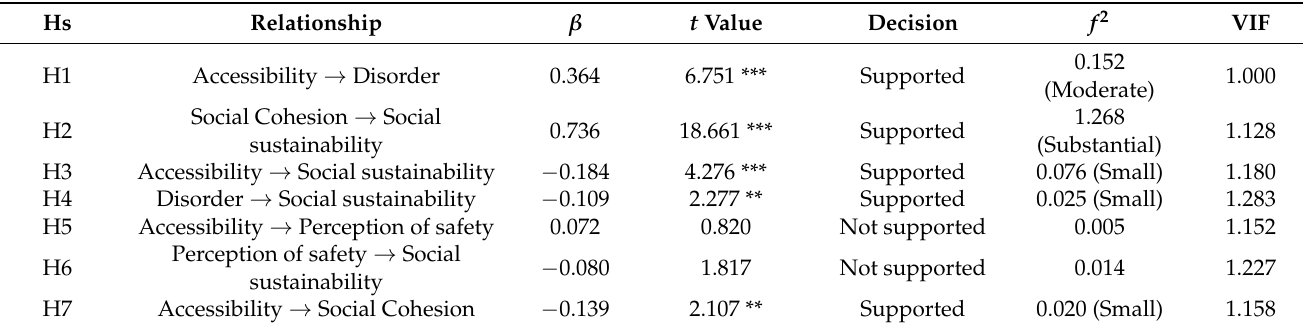
Table 4. Path coefficient and hypothesis testing (direct effects).